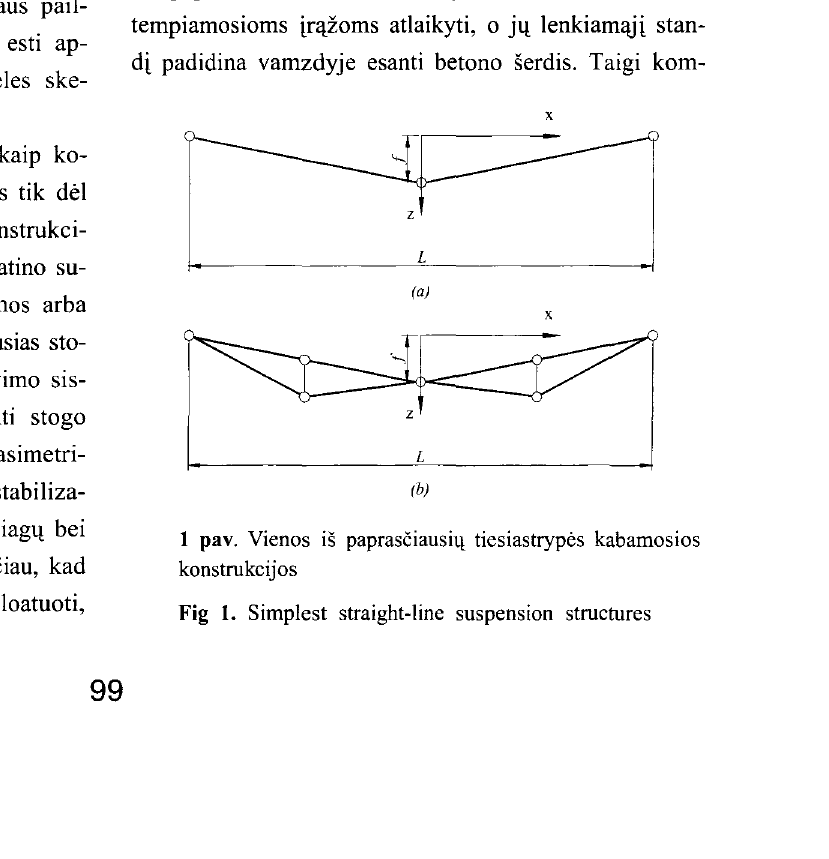
Fig 1. Simplest straight-line suspension